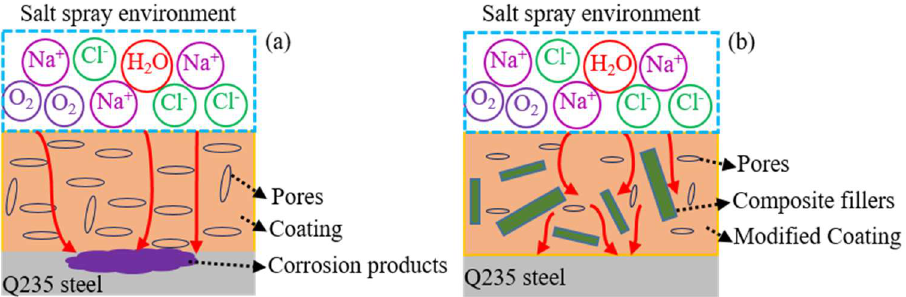
Figure 10. The protective mechanism of the composite coating on the substrate metal, ( a ) waterborne polyurethane coating; ( b ) modified composite coating.